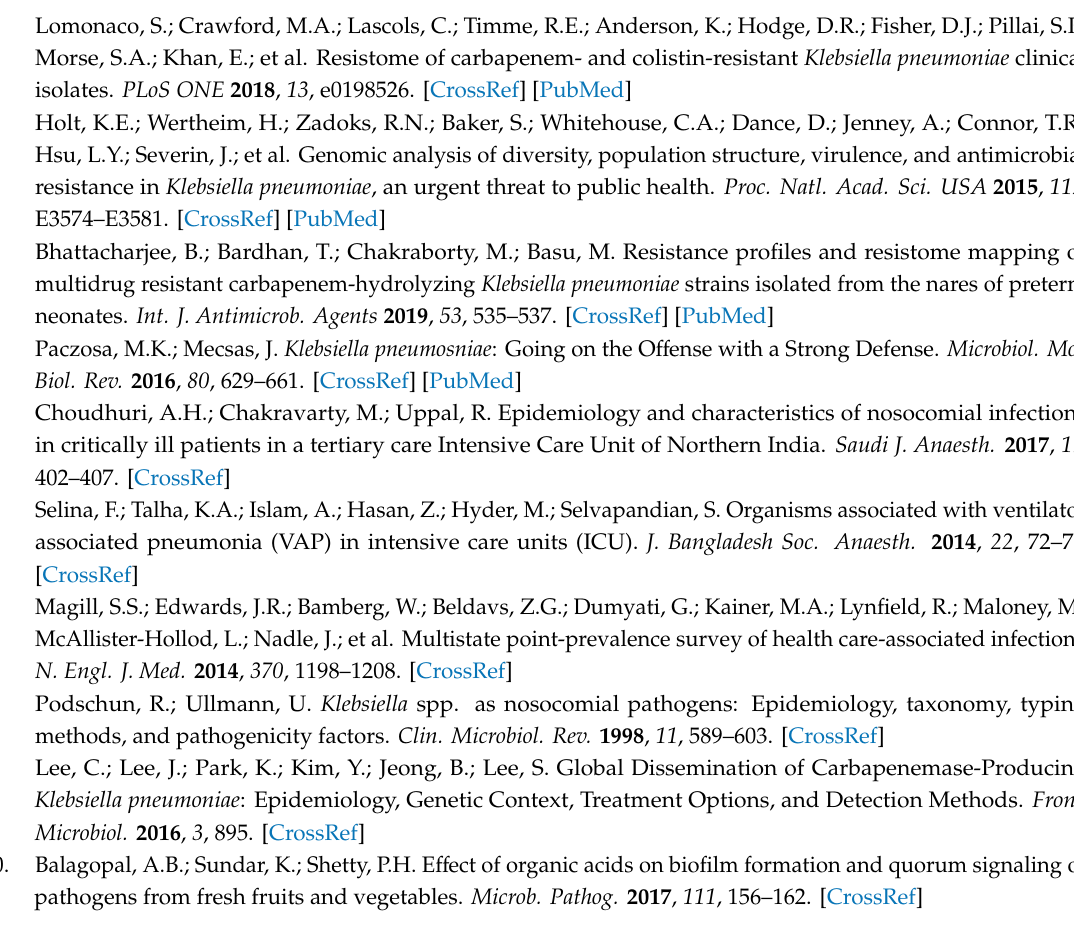
Supplementary Figure S1: Scanning electron micrographs of JNM11.C4 cells at 10,000 × magnification; Supplementary Table S1: Time-kill assay analyses results of the K. pneumoniae isolate, JNM11.C4 after multiple testing correction; Supplementary Table S2: The summary of the e ffi cacy of LA against planktonic carbapenem-hydrolyzing K. pneumoniae cells across isolates, as determined using log (10) CFU di ff erences, and the p -values after multiple testing corrections for the relevant comparisons are tabulated here; Supplementary Table S3: Bactericidal e ffi cacy results of di ff erent percentages of LA on JNM11.C4 isolate after biofilm formation. The tabulated p -values are those of relevant comparisons; Supplementary Table S4: The summary of the e ffi cacy of lactic acid against sessile, biofilm-forming cells across isolates as determined using log (10) CFU di ff erences, and the p -values after multiple testing corrections for the relevant comparisons are tabulated